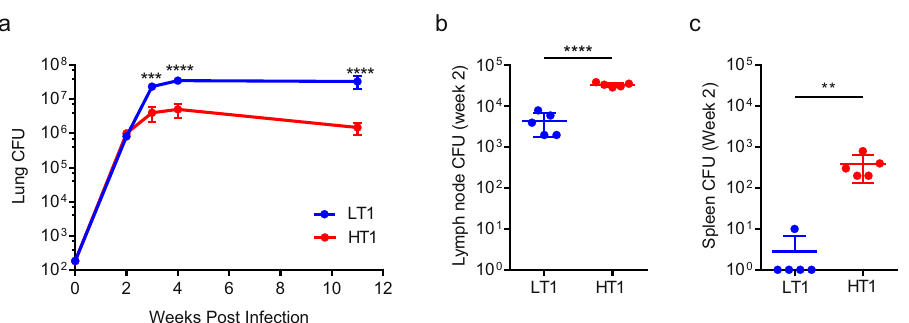
Fig. 1 Increased dissemination of Mtb to lymph node and spleen in Mtb-HT1 infected mice. C3HeB/FeJ mice were infected with ~100 CFU of the indicated strain via Glas-Col aerosol exposure. At the indicated time following infection, mice were sacri fi ced and CFU was determined in lung ( a ), draining lymph nodes ( b ) and spleen ( c ). Sample size of n = 5 mice were included for each strain and for each time point. Data are presented as mean values + / − SD. Signi fi cance was determined using two-way ANOVA with Bonferroni post-test ( a ) and unpaired t tests ( b and c ). ** P = 0.0095, **** P < 0.0001. The data are representative of one of two individual experiments with Mtb-HT1 and Mtb-LT1 and was repeated with Mtb-HT2 and Mtb-LT2. Source data are provided as a Source Data fi le.